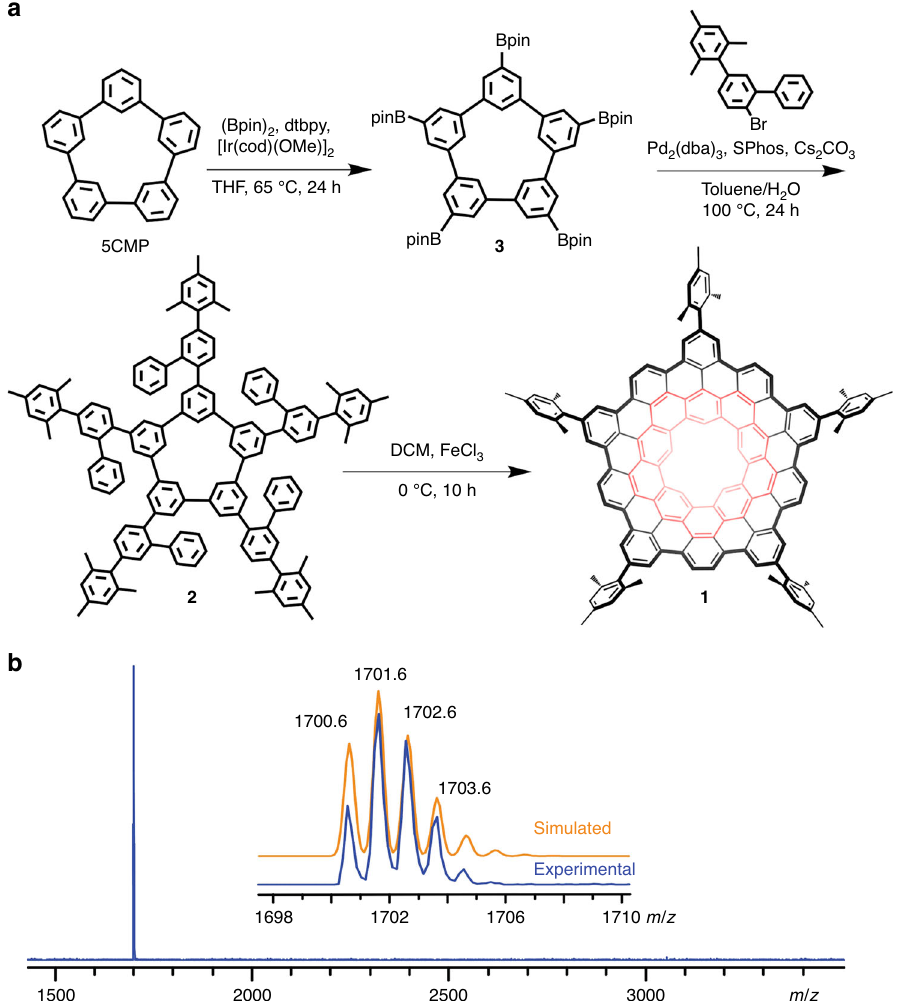
Fig. 2 Synthetic route and mass spectra of 1. a The synthetic route toward 1 . The quintulene unit in 1 is highlight in red. b . The mass spectrum of 1 . The isotopic distribution for the mass peak of 1 is shown as the insert fi gure. (Bpin) 2 , bis(pinacolato)diboron; dtbpy, 4,4 ′ -di-tert-butyl-2,2 ′ -dipyridyl; DCM, dichloromethane; THF, tetrahydrofuran; [Ir(cod)(OMe)] 2 , bis(1,5-cyclooctadiene)di- μ -methoxydiiridium(I); Pd 2 (dba) 3 , tris(dibenzylideneacetone) dipalladium(0); SPhos, 2-dicyclohexylphosphino-2 ’ ,6 ’